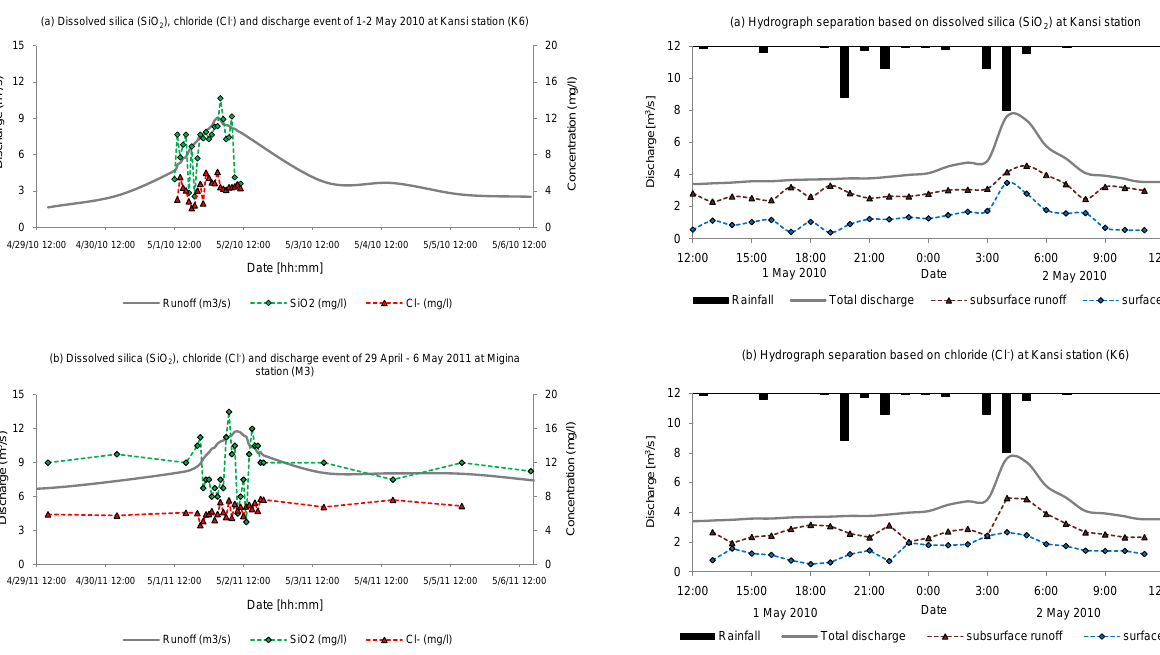
Figure 4 Results of two-component hydrograph separations based on dissolved silica (a) and chloride (b) Fig. 4. Results of two-component hydrograph separations based for subsurface and surface runoff for event K6 (see Fig. 2a) investigated from 1 May 2010 at 12:00 to 2 on dissolved silica (a) and chloride (b) for subsurface and surface May 2010 at 11:00 at Kansi station. runoff for event K6 (see Fig. 2a) investigated from 1 May 2010 at 12:00 to 2 May 2010 at 11:00 at Kansi station.